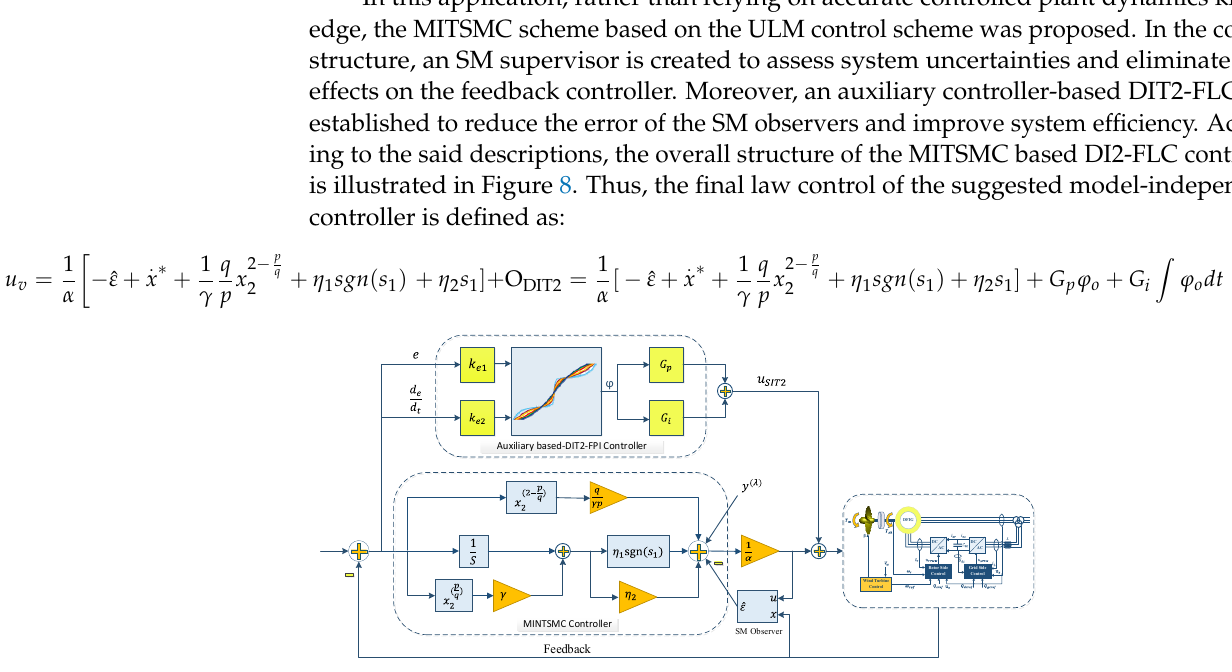
Figure 8. Structure of the proposed MINTSMC scheme-based DIT2-FPI controller.